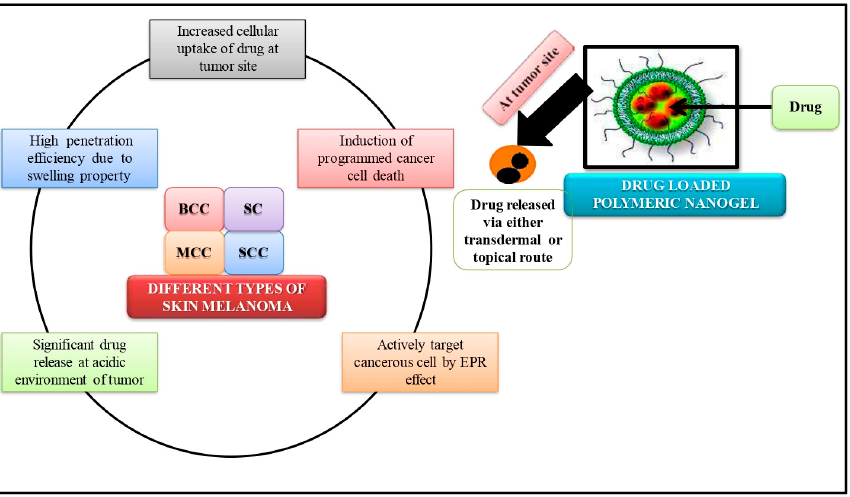
Figure 3. Mechanisms of polymeric nano-gels in the treatment of skin cancer. BCC: Basal cell carcinoma, SCC: Squamous cell carcinoma, SC: Super fi cial carcinoma, MCC: Merkel cell carcinoma.